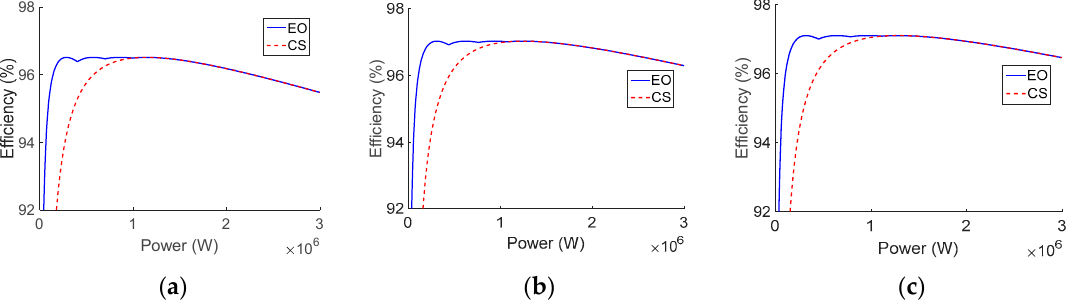
Figure 14. Efficiency of Power-One ULTRA-750-TL-OUTD-4-US with average current-sharing control method ( CS ) and efficiency-oriented method ( EO ). ( a ) 585 V. ( b ) 746 V. ( c ) 800 V.